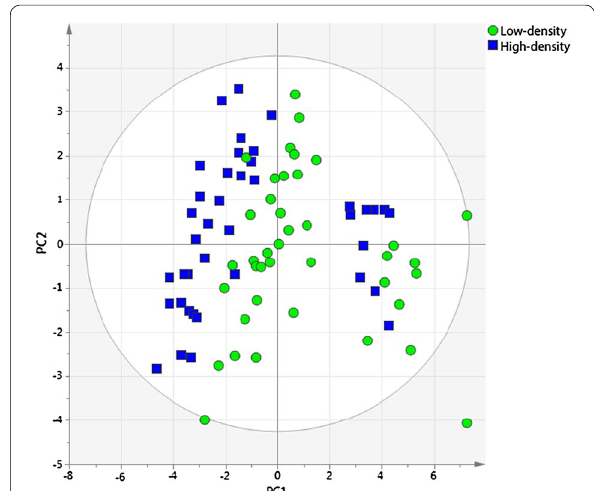
Fig. 7 PCA score plot describing the MC with adjusted coordinates (PC1 and PC2) for maximum variation between the replicates. Replicates close in space have a similar MC. The replicates are coloured according to the parameters of low- and high-density spruce